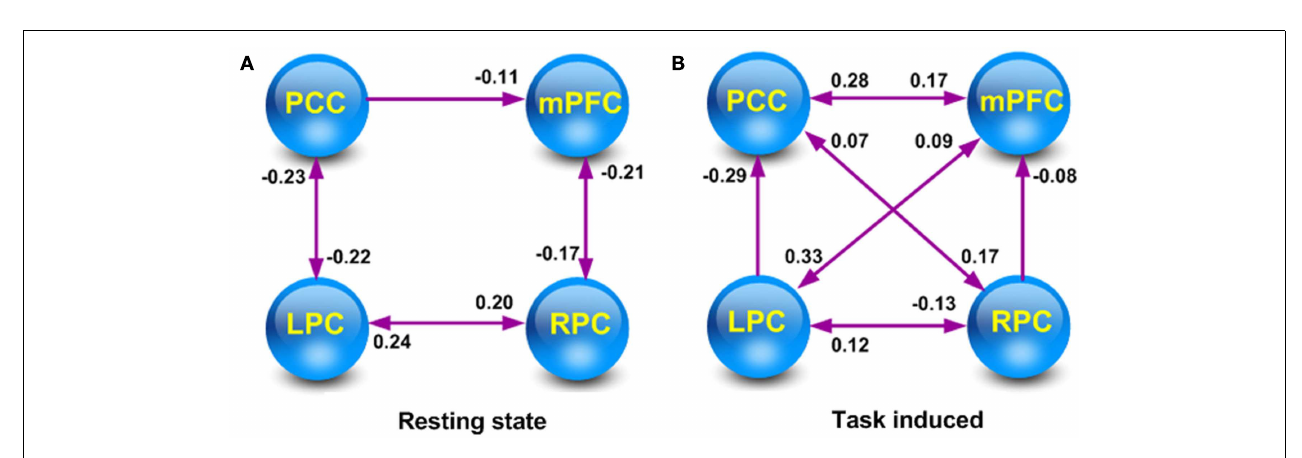
mean for the coupling parameters are shown alongside the connections (arrows).Two-headed arrows indicate bidirectional (reciprocal)